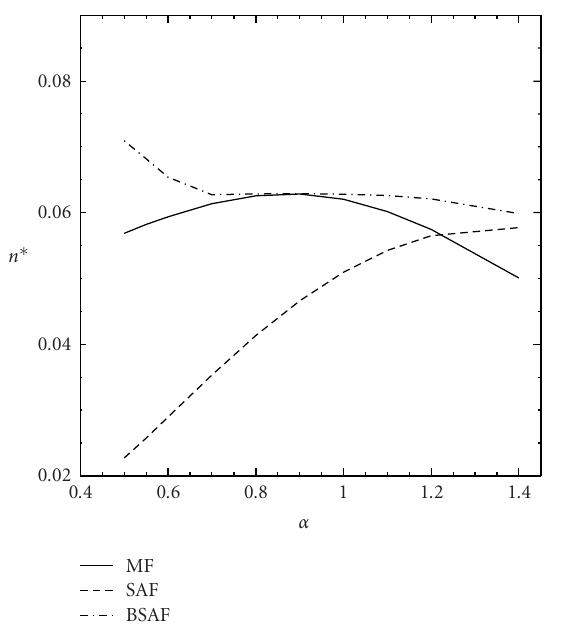
Figure 3: The expected number density of detections n ∗ as a func- tion of α for γ = 0 for the BSAF ( c has been obtained by maximising the number of detections for each value of α ), MF, and SAF